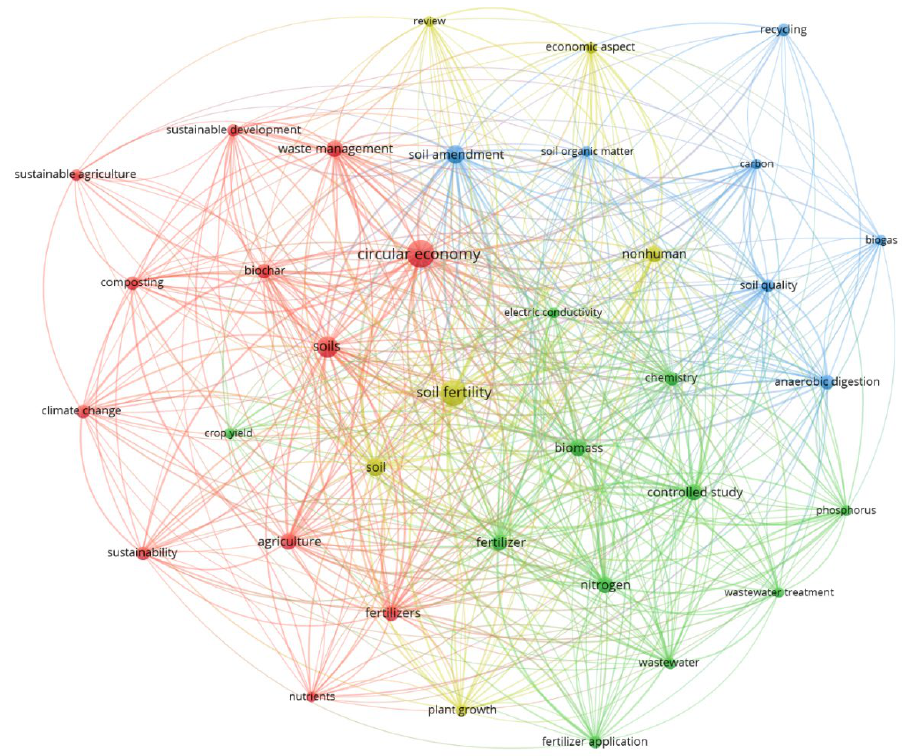
Figure 1. Co-occurrence network map of the most used keywords related to “circular economy” and “soil fertility” in the documents indexed by Scopus, 2016–2022.